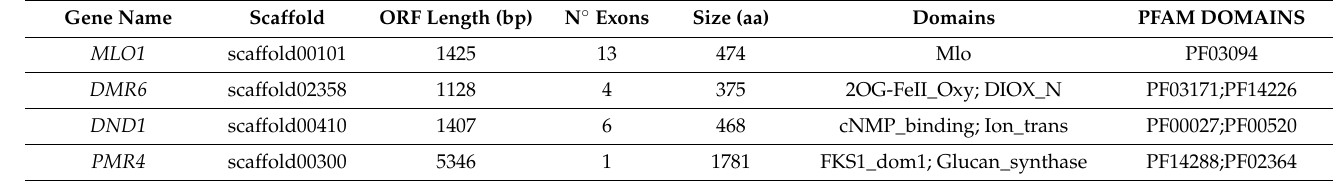
Table 1. S-genes detected in the C. mollissima v1.1 genome and protein domain annotations.